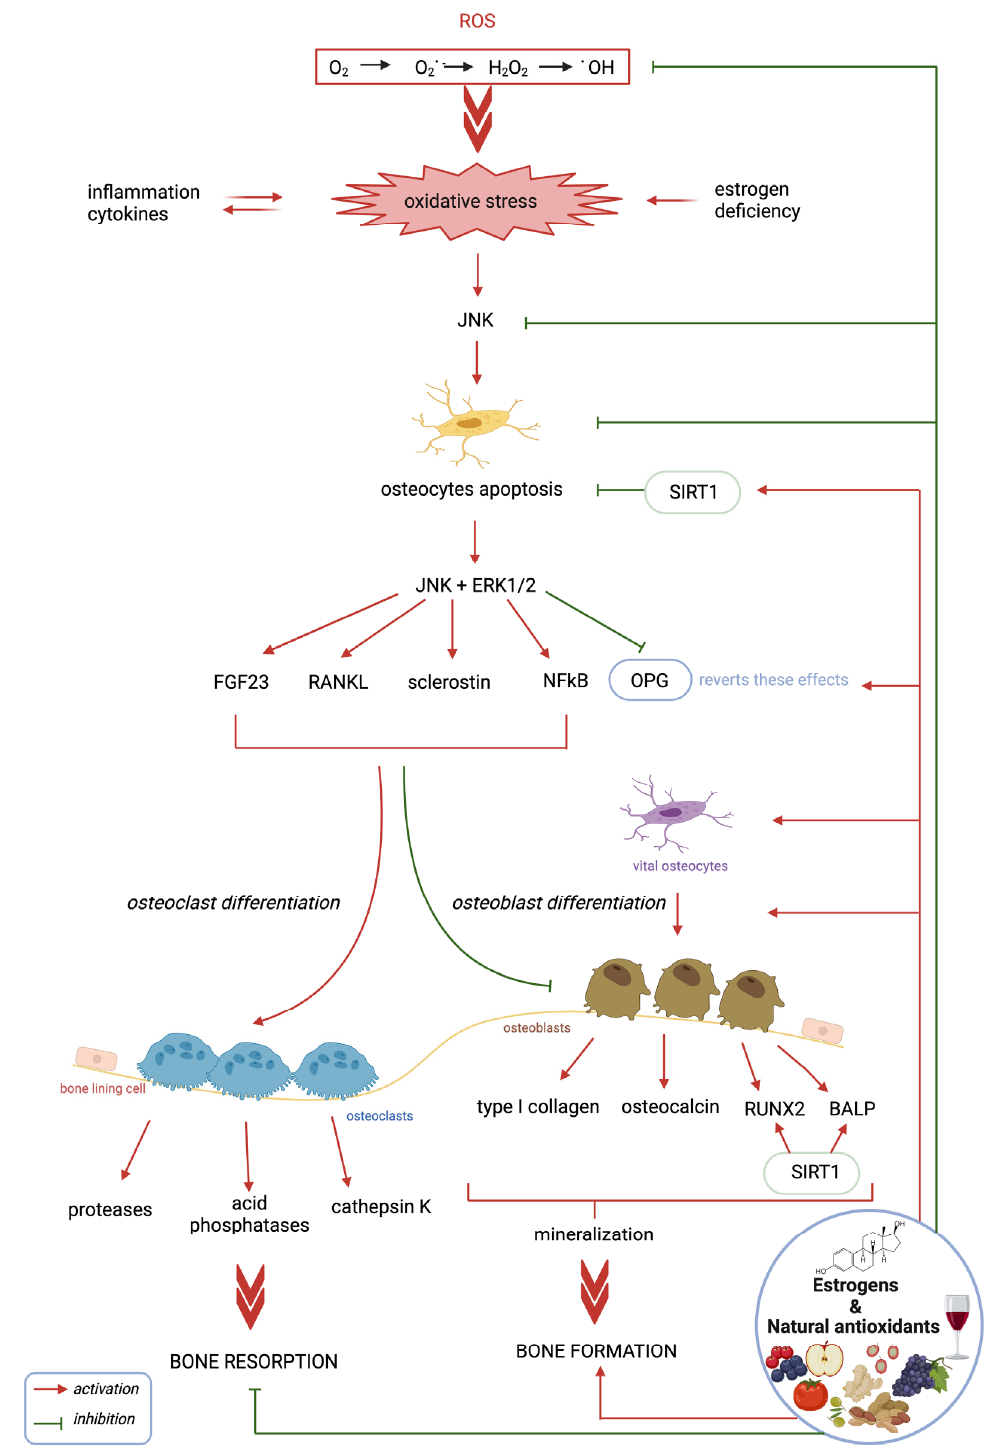
Figure 1. Effect of OS, antioxidants, and estrogens on osteocytes and the production of some factors involved in the bone remodeling process. OS, through JNK signaling, induces abnormal osteocyte apoptosis, which plays a central role in the regulation of specific osteocyte-related factors that induce osteoclastogenesis and bone resorption. Natural antioxidants and estrogens prevent and inhibit these effects by maintaining vital osteocytes and by regulating redox and/or non-redox intracellular mechanisms, thus favoring the process of osteogenesis and bone formation. Figure created with Biorender.com, accessed on 29 January 2023.